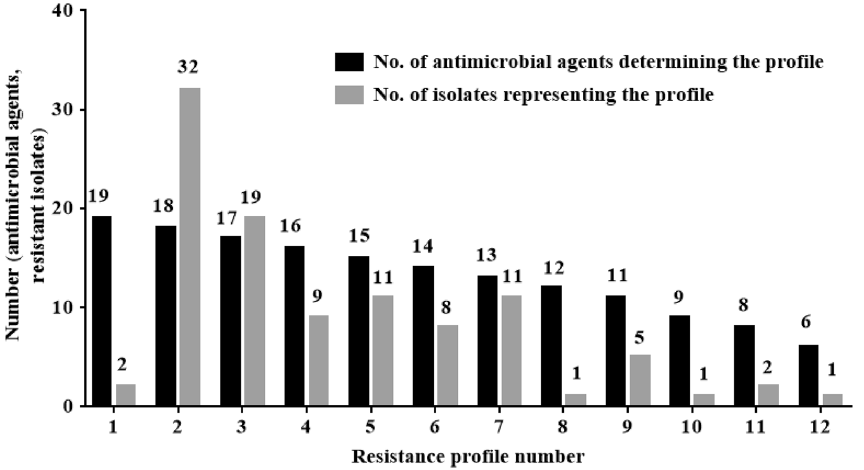
Figure 1. Resistance profiles of A. baumannii isolates against 19 tested antimicrobial agents and the number of isolates representing each